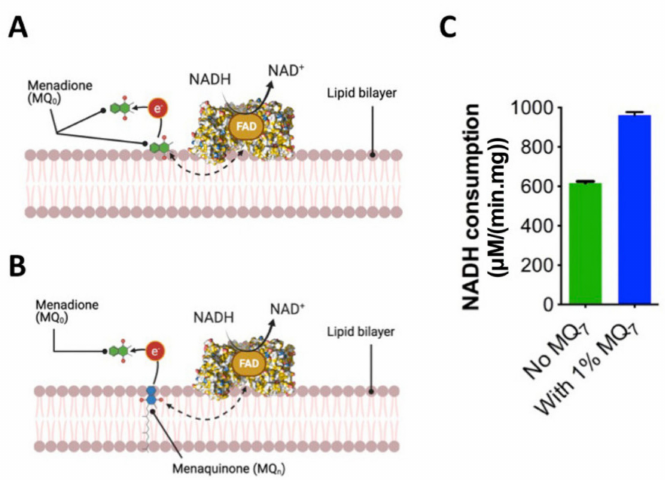
Figure 2. Influence of MQ 7 on efficient Cth NDH-2 catalysis in a membrane-based solution assay. Cth NDH-2 was reconstituted into vesicles composed of either E. coli polar lipid extraction (ECPL) without ( A ) or with ( B ) 1% menaquinone-7 (MQ 7 ). Cth NDH-2 is represented as a space-filling model (PDB:6BDO). Assays were performed using menadione as a soluble electron acceptor in lieu of a terminal oxidase as in nature. ( C ), V max values obtained with and without MQ 7 . Experiments were performed in triplicate, and either error (standard deviation) is